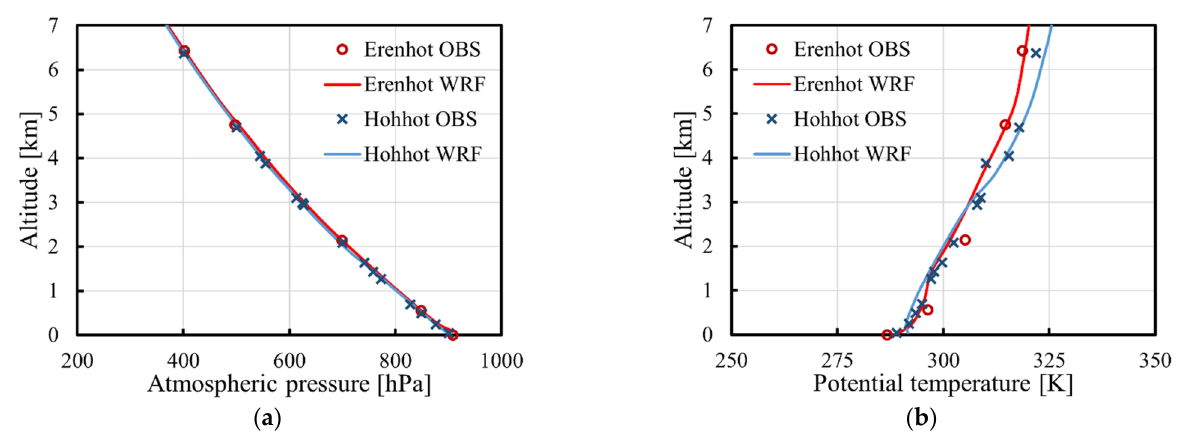
Figure 8. Profiles of ( a ) atmospheric pressure and ( b ) potential temperature above the main landing area from WRF and upper-atmosphere sounding data at 00:00 LST on 28 September 2008.